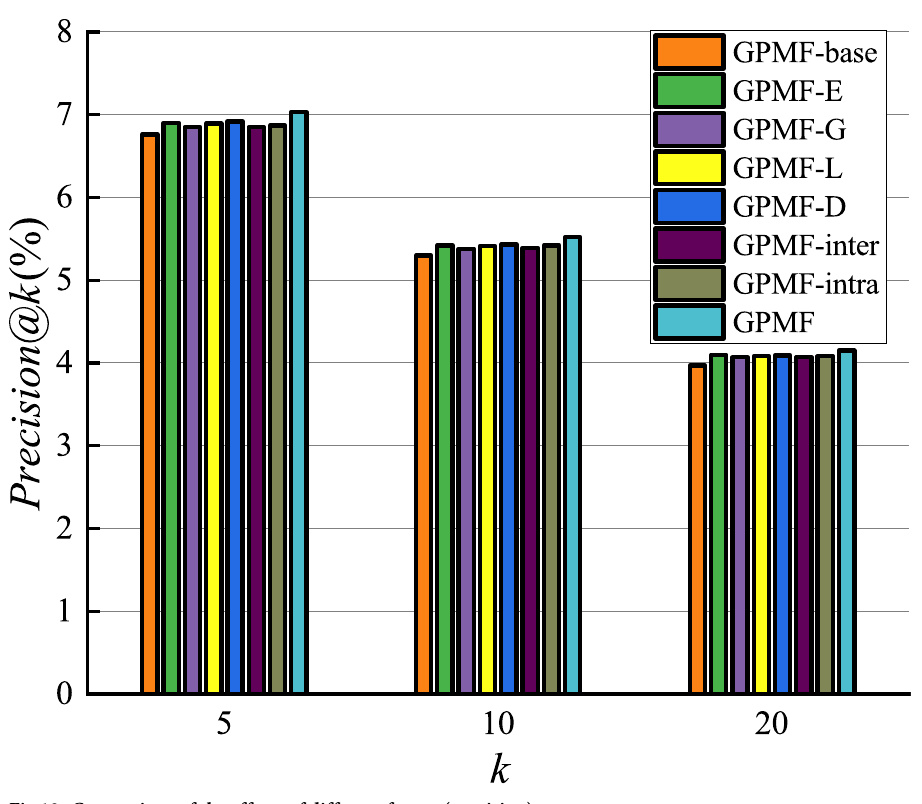
Fig 13. Comparison of the effects of different